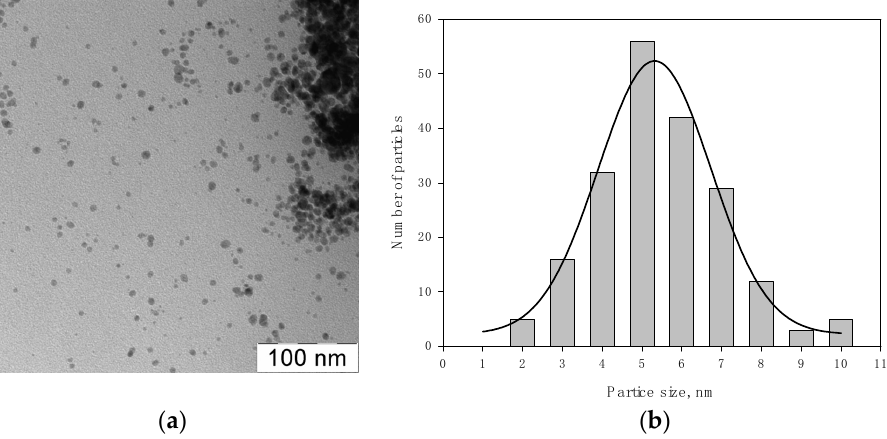
Figure 5. TEM micrographs of Ag NPs in a bright ( a ) field and the histogram of the distribution of Ag nanoparticles from the Ag NPs/2 ‐ propanol/HBPAPES system ( b ).